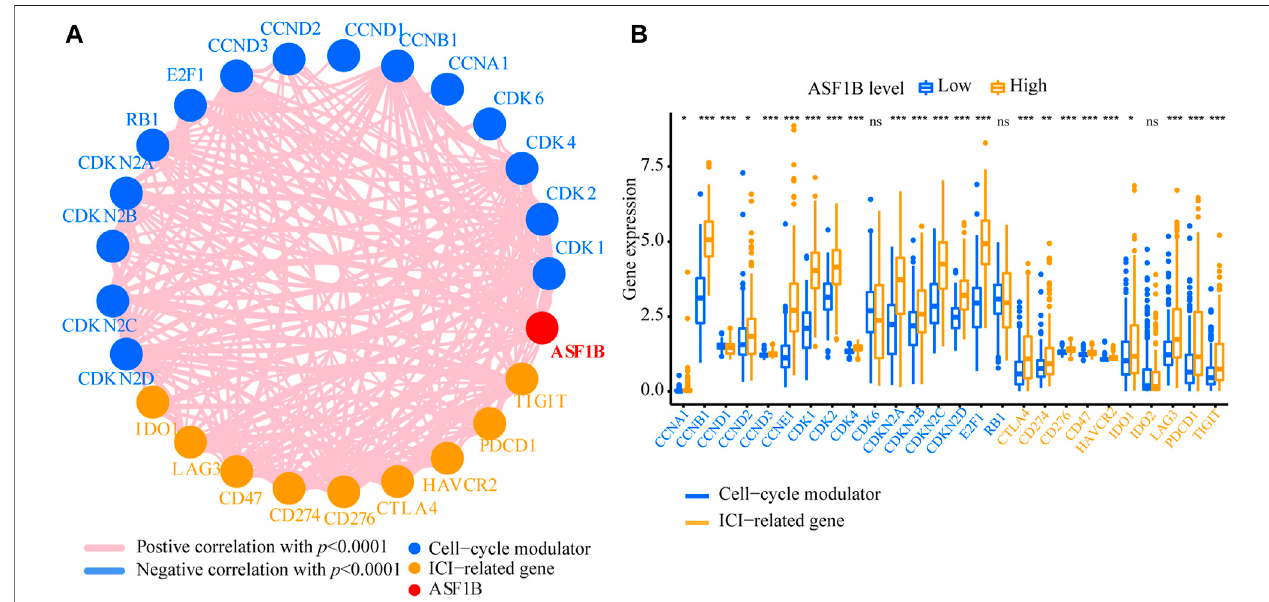
FIGURE 7 | The relationship of cell-cycle modulators and immune checkpoints between ASF1B-high and ASF1B-low groups. (A) Correlation of ASF1B, cell-cycle modulators, and immune checkpoints. (B) The comparison of cell-cycle modulators and immunecheckpoints between ASF1B-high and ASF1B-low groups. * p < 0.05; ** p < 0.01; *** p <